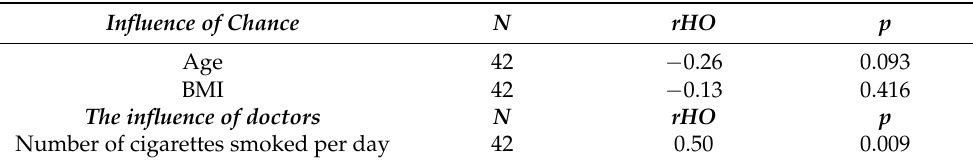
Table 10. Influence of chance vs. type of aneurysm. Influence of Chance vs. Type of Aneurysm N M